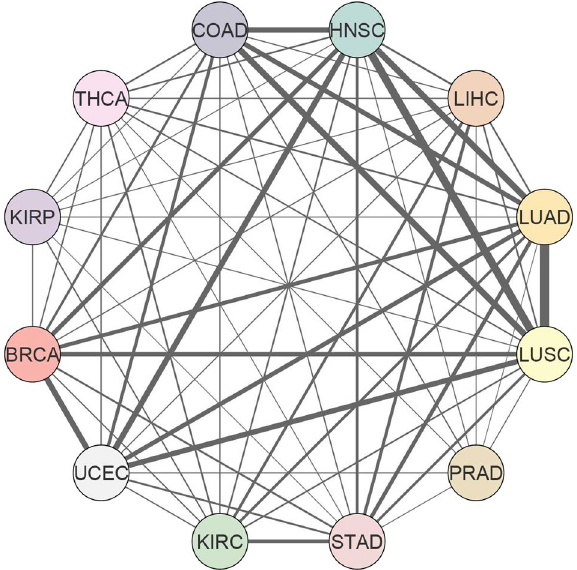
Figure 4. Pan-cancer analysis of the differential interactome. Similarity network showing pairwise correlations among 12 cancer types based on the Jaccard